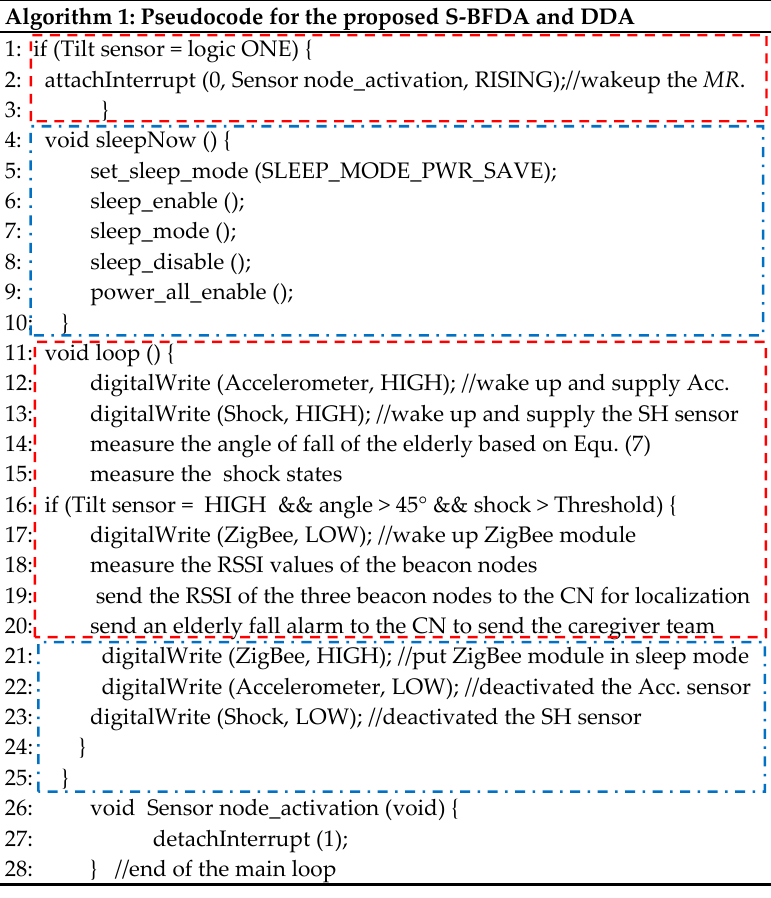
Algorithm 1: Pseudocode for the proposed S-BFDA and